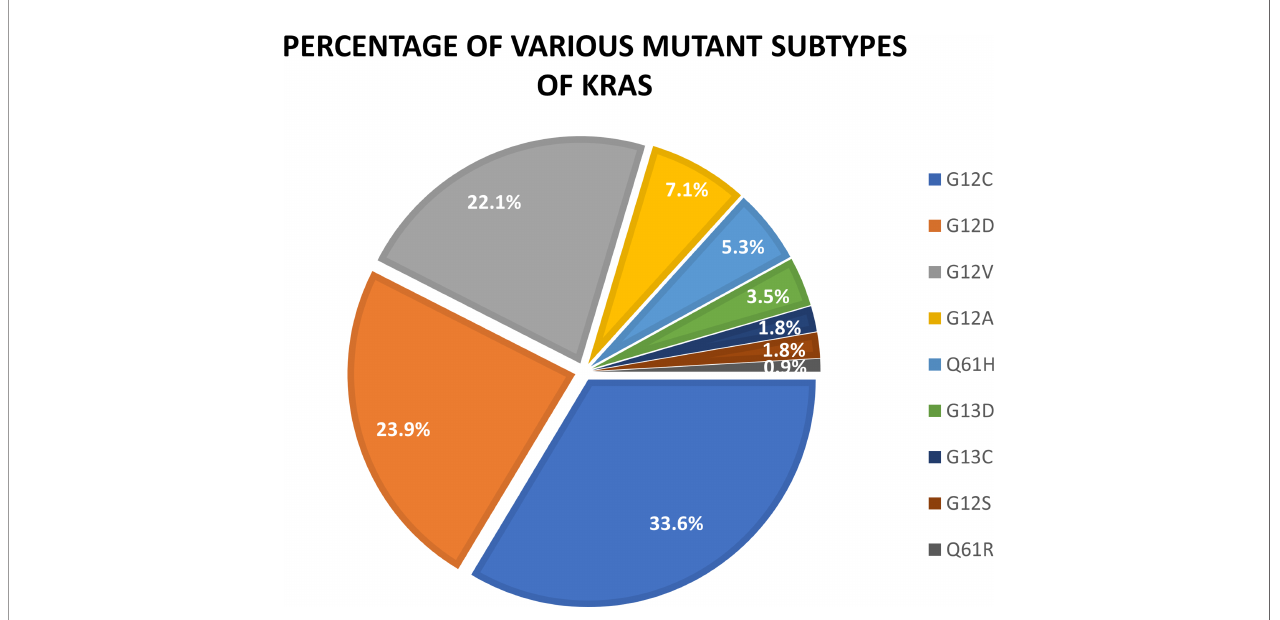
FIGURE 2 | Percentage of various mutant subtypes of KRAS.